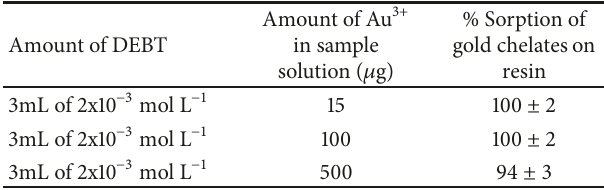
Table 1: Effectof ligand concentrationof retentionof metalchelates. Amount of DEBT